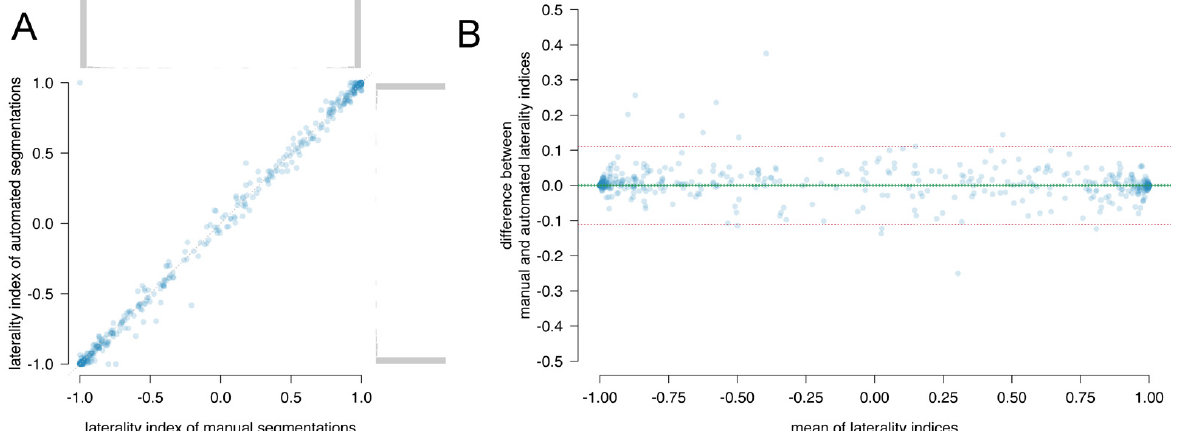
Figure 1. Comparison between automated and manual segmentations for the laterality index in ( A ) a correlation plot with histograms in the margin and ( B ) a Bland–Altman plot. In the scatterplots, each dot represents the laterality indices of one patient. The diagonal indicates the identity line. The Bland–Altman plots of the mean of laterality indices versus the difference between the laterality indices. Each dot represents one patient. The bias is plotted as solid green line with 95% CI as dotted green lines. The limits of agreement are plotted as dotted red lines.